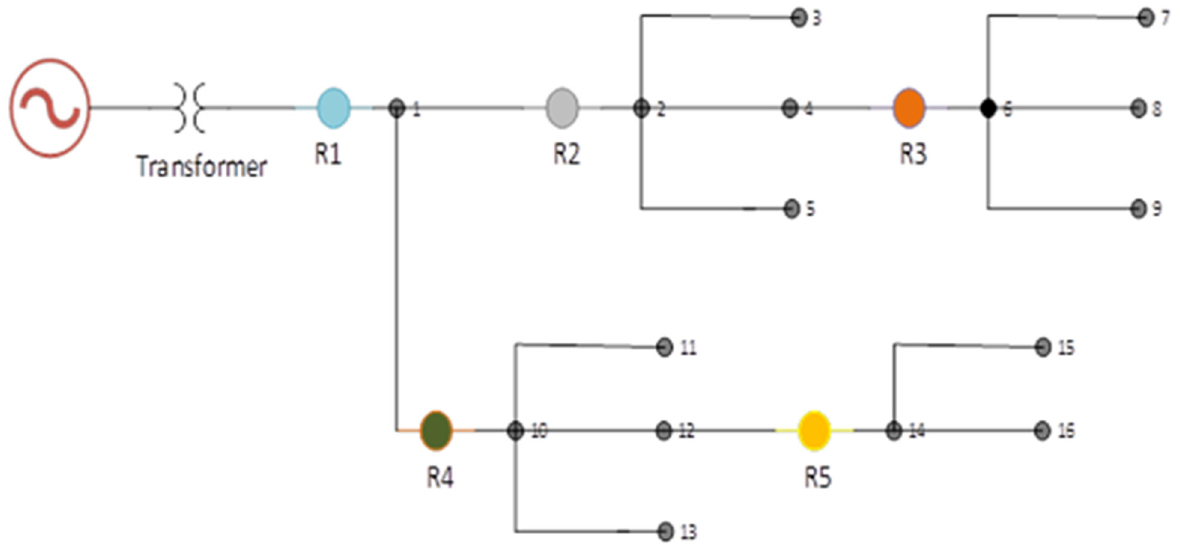
Figure 7. Simulation setup of proposed work (a case study).